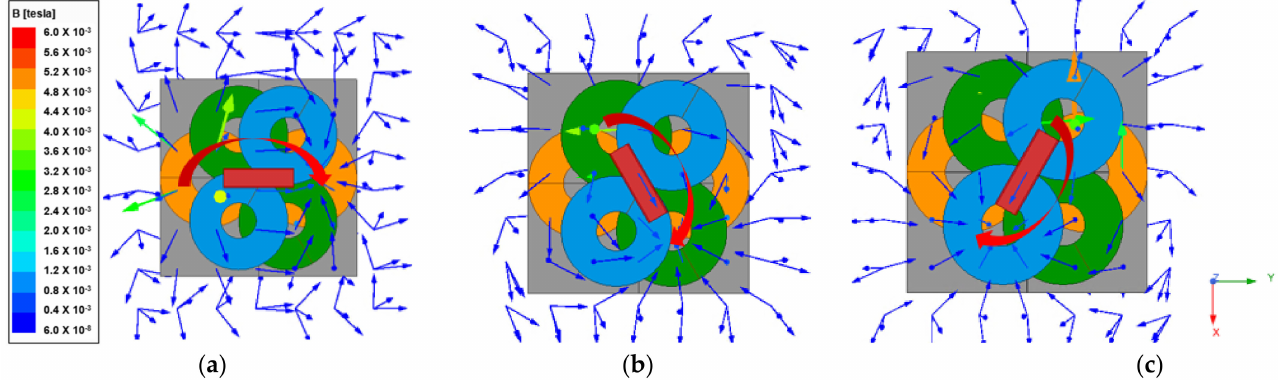
Figure 8. Simulation result of magnetic field vector direction and RX coil position according to TX coil on/off. ( a ) Magnetic field direction when TX coil 1 is on; ( b ) Magnetic field direction when TX coil 2 is on; ( c ) Magnetic field direction when TX coil 3 is